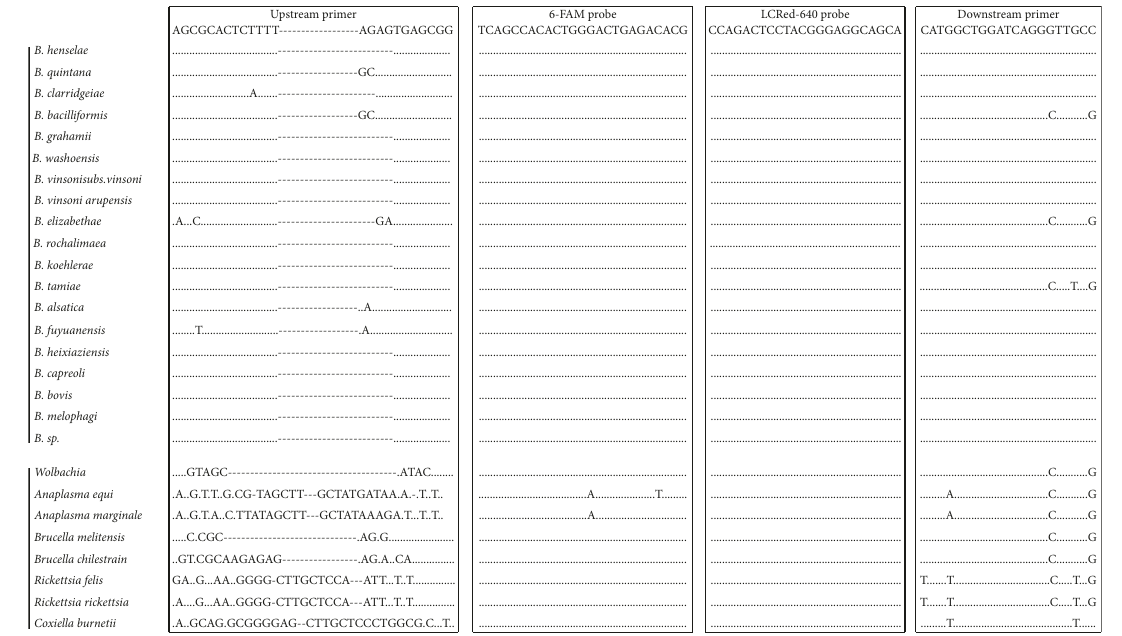
Figure 1: Alignment of oligonucleotides for the pan- Bartonella FRET-qPCR based on the 16S rRNA used in this study. Primers and probes are shown at the top of the boxes. Dots indicate nucleotides identical to primers and probes, and dashes denote absence of the nucleotide. The upstream primers and two probes are used as the indicated sequences, while the downstream primer is used as the antisense oli- gonucleotide. The designed oligonucleotides show minimum mismatching with Bartonella spp. (0 mismatches with 14 species, 1 mismatch with 3 species, 2 mismatches with 1 species, and 4 mismatches with 2 species) but 11–29 nucleotide mismatches with the related non- Bartonella species. The 6-FAM label is directly attached to the 3-terminal nucleotide of the fluorescein probe, and the LCRed-640 fluorescein label is added via a linker to the 5 ′ end of the LCRed-640